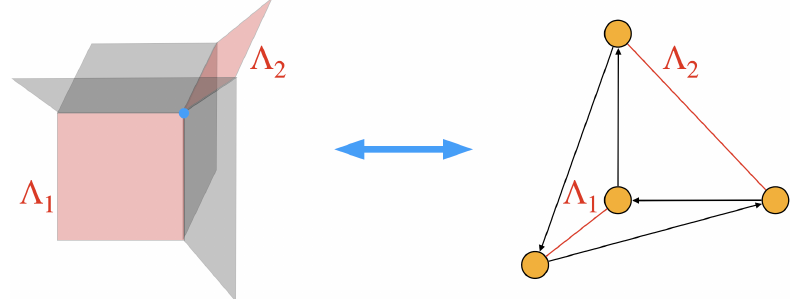
Figure 5 . A vertex in a BFT 2 and the corresponding tetrahedron in the dual